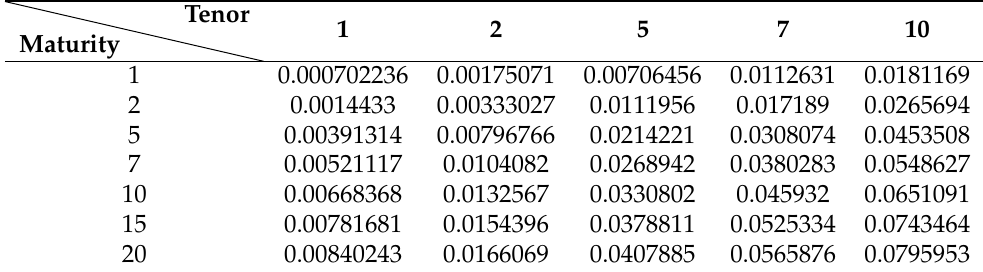
Table A3. Market data containing the swaption prices on 30 December 2019.